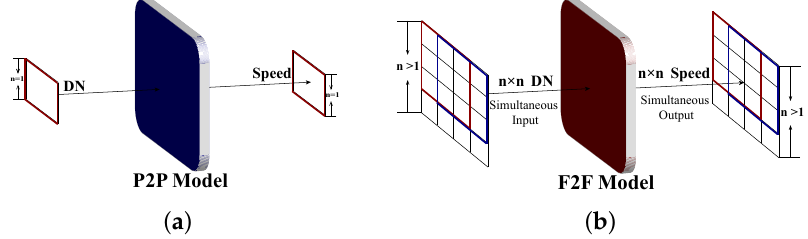
Figure 2. ( a ) shows the P2P method and ( b ) is a schematic diagram of